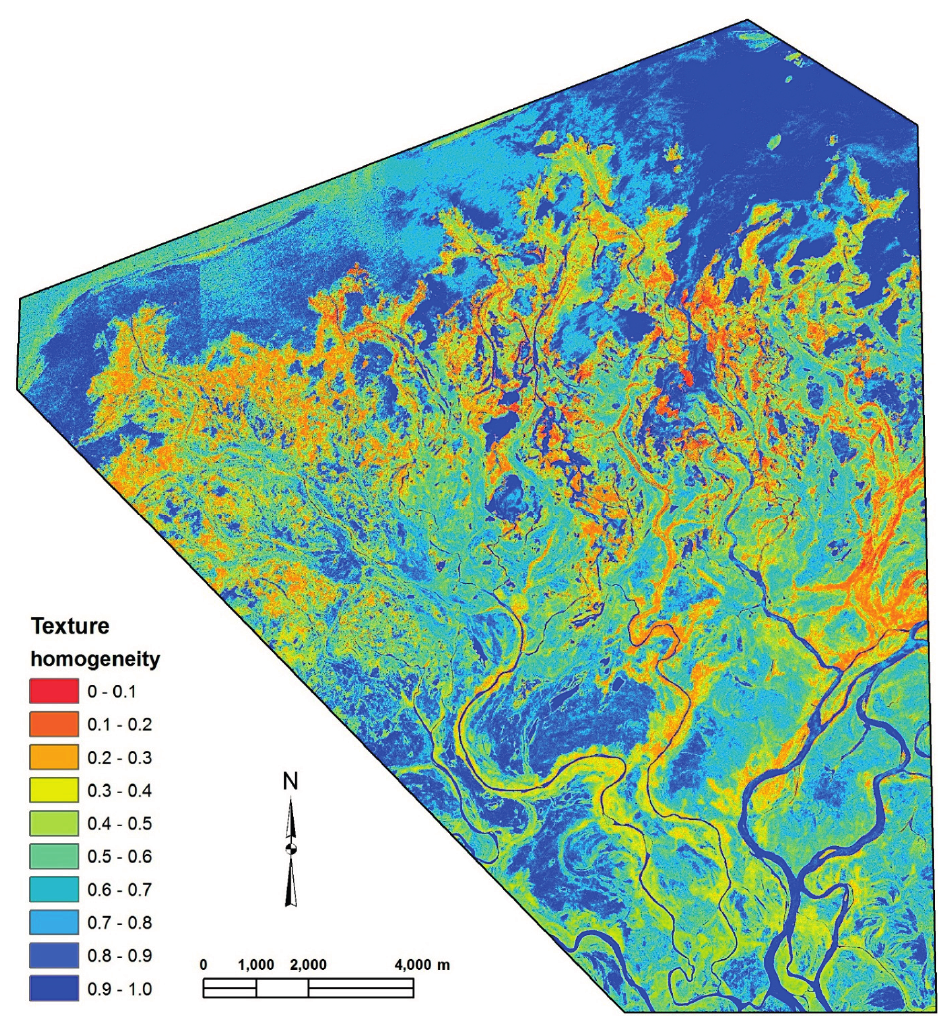
Figure 4. Homogeneity texture measure based on the grey-level co-occurrence matrices